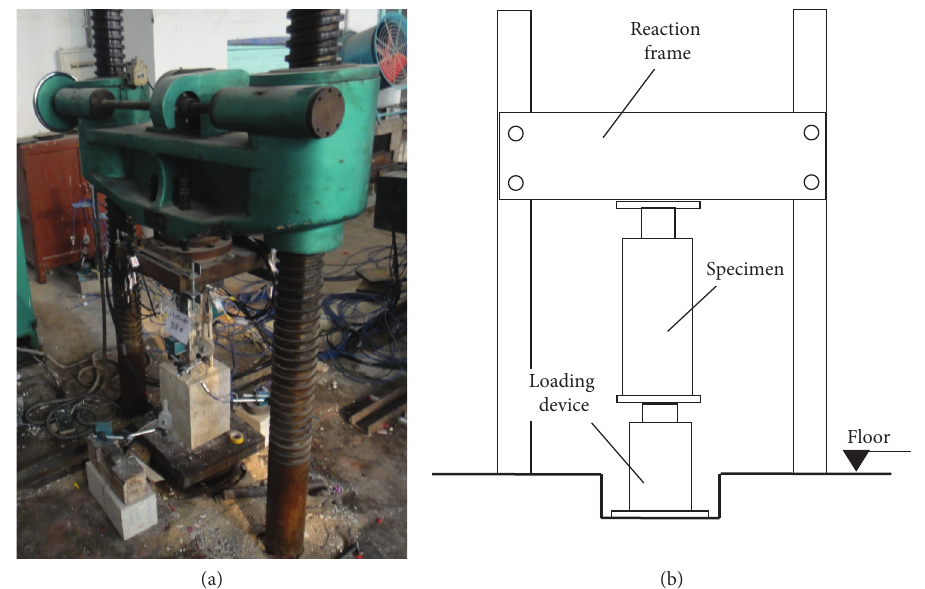
Figure 3: Experimental program: (a) testing machine; (b) testing system.